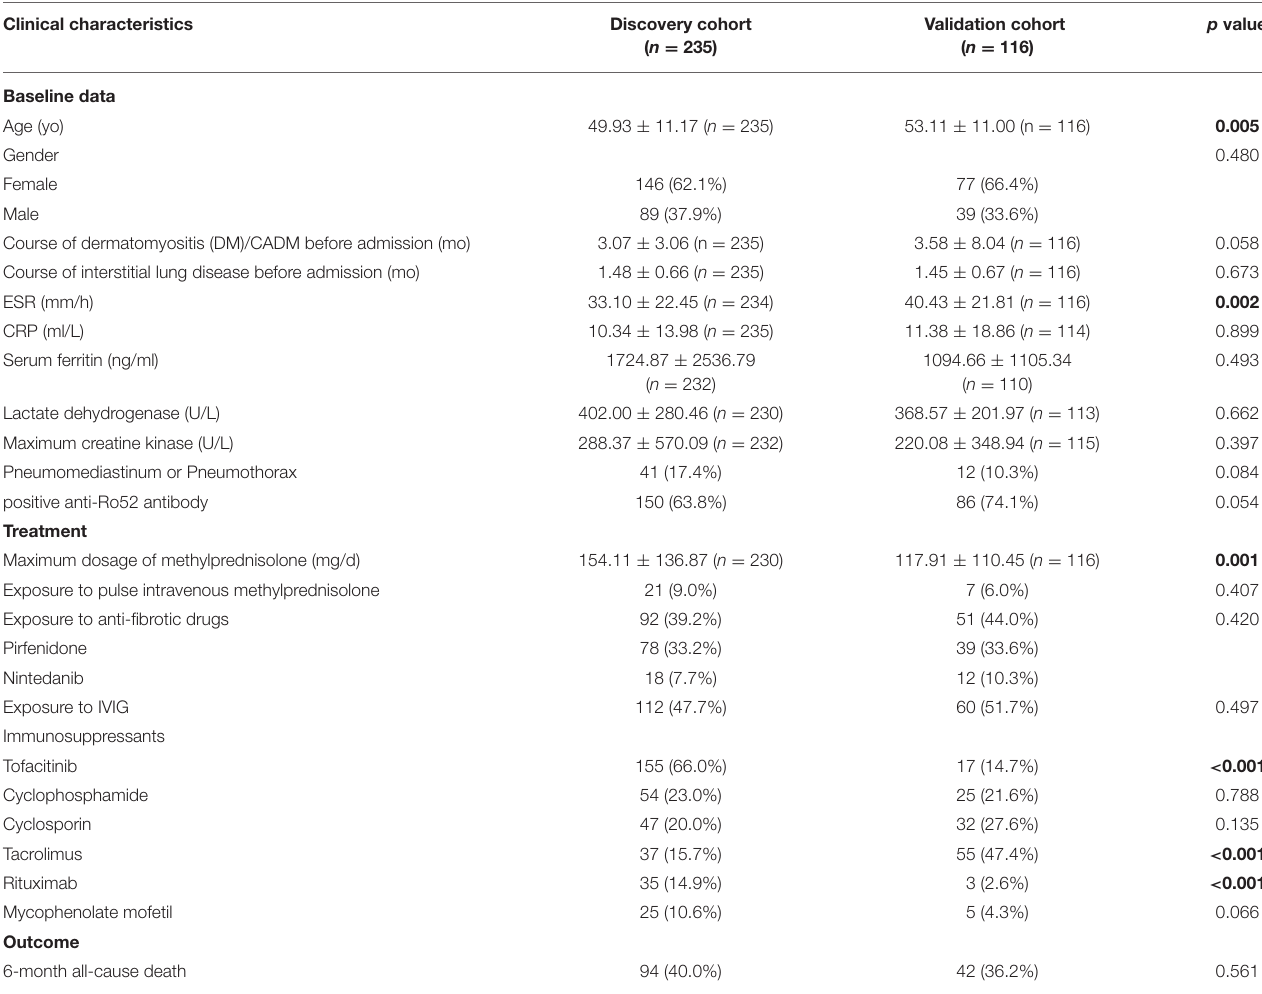
TABLE 1 | Clinical characteristics of patients in the discovery and validation